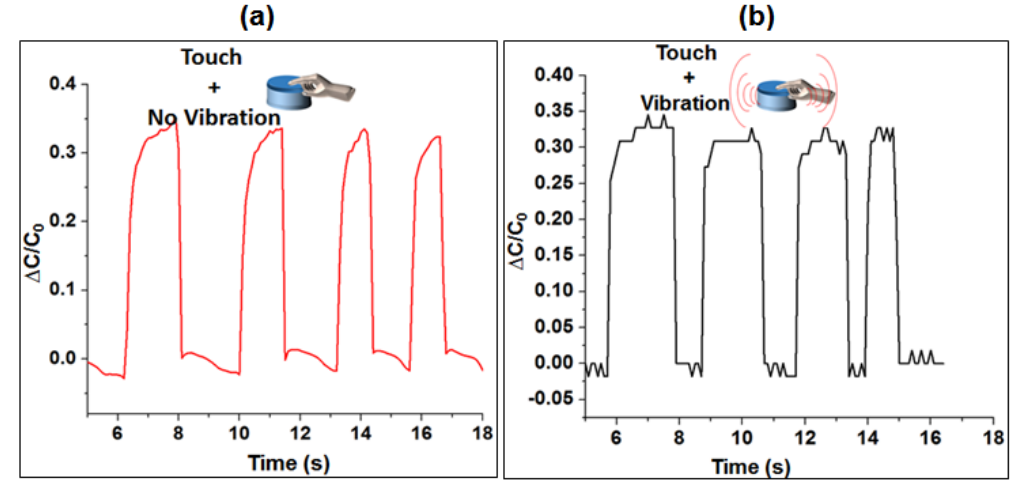
Figure 7. Response of the capacitive sensing layer with and without actuation; ( a ) Sensor output when touched and vibration is OFF; ( b ) Sensor’s output when touched and vibration is ON.